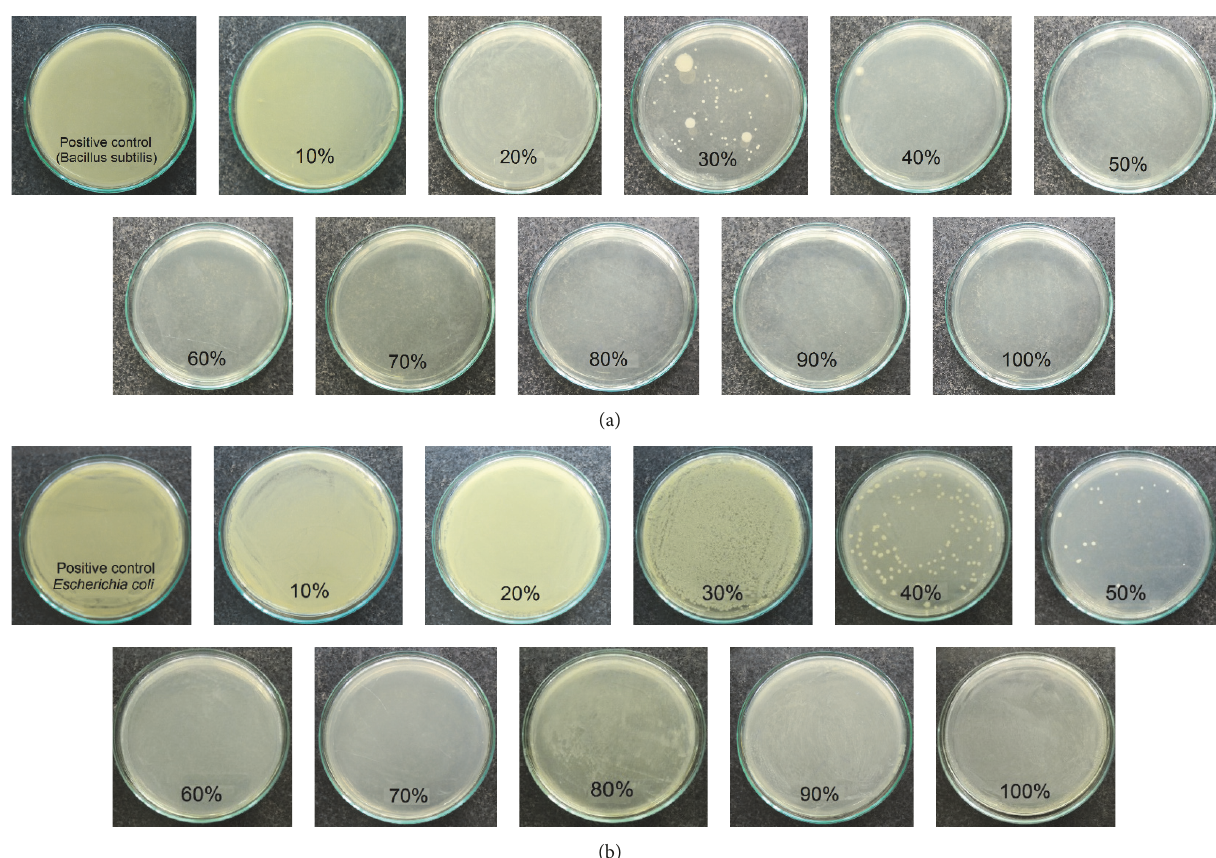
Figure 4: MIC of FFAs against Bacillus subtilis (a) and Escherichia coli